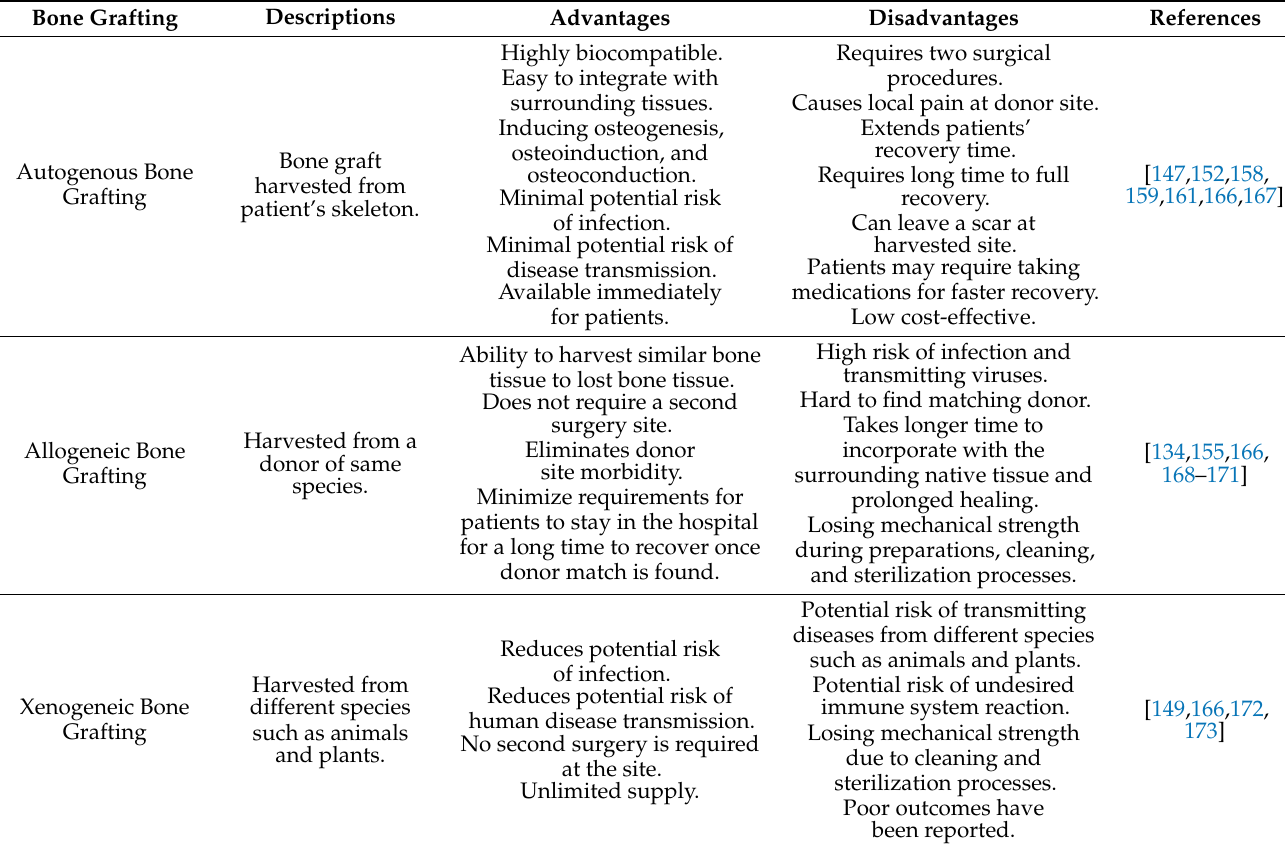
Table 1. Advantages and disadvantages of bone graft